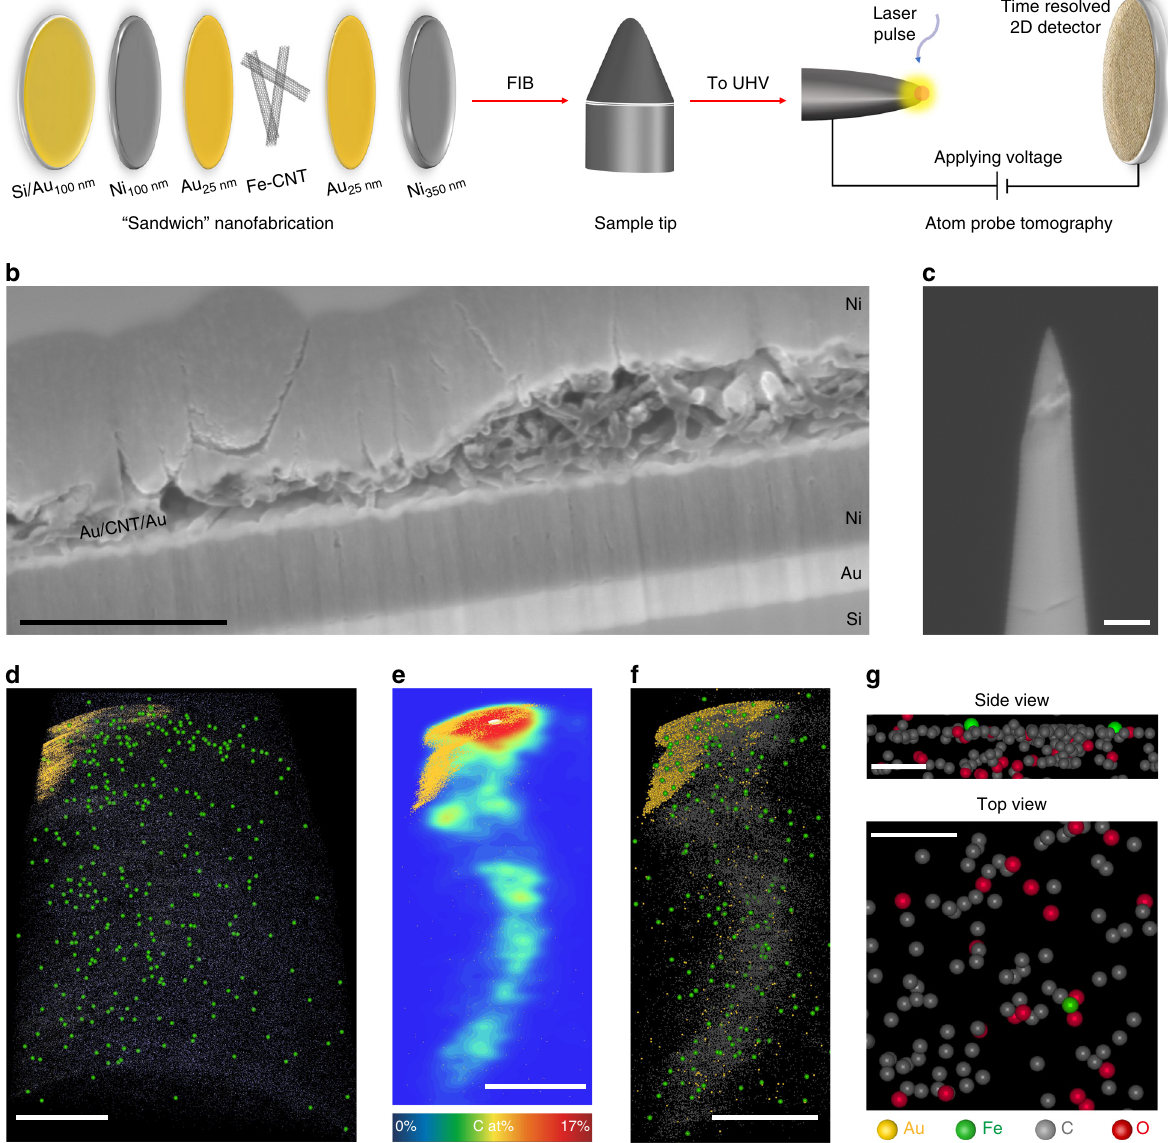
Fig. 2 Atom probe tomography of Fe-CNT catalyst. a The schematic of the nanofabrication procedure of APT sample tips. b The cross-section SEM image of a catalyst sandwich after FIB cutting. c SEM image of the fi nal APT specimen tip anchored on a Si microtip after sharpening. d Reconstructed APT data for a region containing Fe-CNT, with ( e ) a 2D contour plot of C atomic concentration and f the corresponding reconstruction for a region of 40 × 40 × 80 nm surrounding a CNT. g Side and top view of CNT planes, where single Fe atoms may have direct coordination with both C and O. The vacant space is mainly due to the low detection ef fi ciency of atoms. Atom labels, Au in yellow, Fe in green, C in gray, and O in red in d – g ; Scale bars, 500 nm in b , 200 nm in c , 20 nm in d – f , and 2 nm in pre-calibrated by the redox reaction of [Fe(CN 6 )] 4 − /[Fe(CN 6 )] 3 − (Supplementary Fig. 12, Methods). The potential of reference electrode was double con fi rmed by purging pure H 2 gas onto a physically and electrochemically polished polycrystalline Pt wire or Pt rotation disc electrode at a reasonable rotation speed (Supplementary Fig. 13, Methods). The ORR peak of Fe-CNT was observed in the cyclic voltammetry in O 2 -saturated electrolyte, in contrast with the double layer current when O 2 was switched to N 2 (Supplementary Fig. 14). Figure 3a shows the polarization curves of M-CNTs for their performance screening at a constant catalyst loading of 0.1 mg cm − 2 , together with the H 2 O 2 genera- tion current detected by the Pt ring electrode (Methods). Note that the possible H 2 O 2 decomposition on metal oxides compared